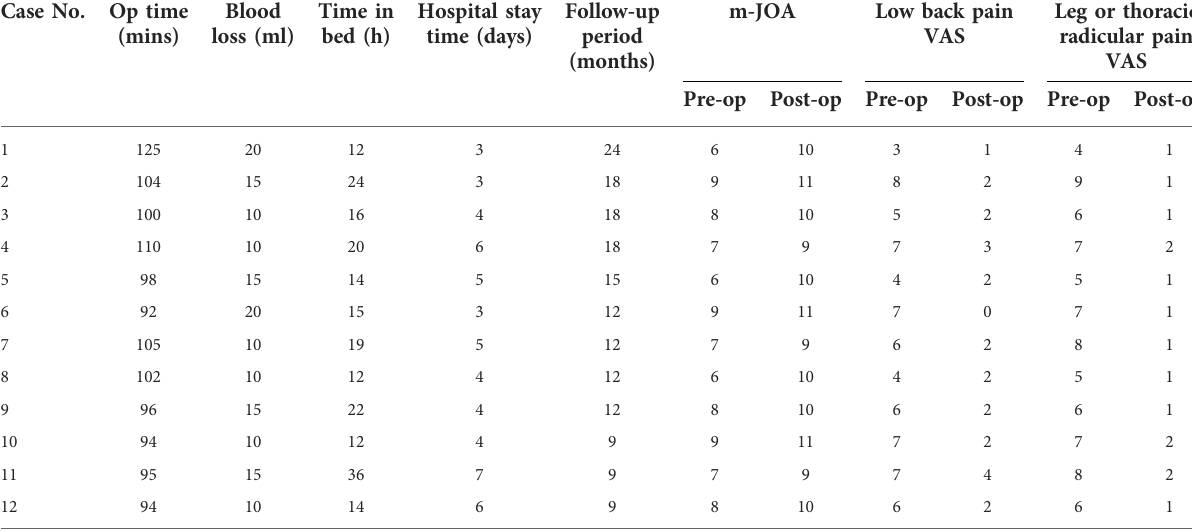
TABLE 5 Operation time, blood loss, time in bed, hospital stay time, follow-up period, and pre- and postoperative m-JOA and VAS assessed 12 months postoperatively or at last follow-up. Case No. Op time